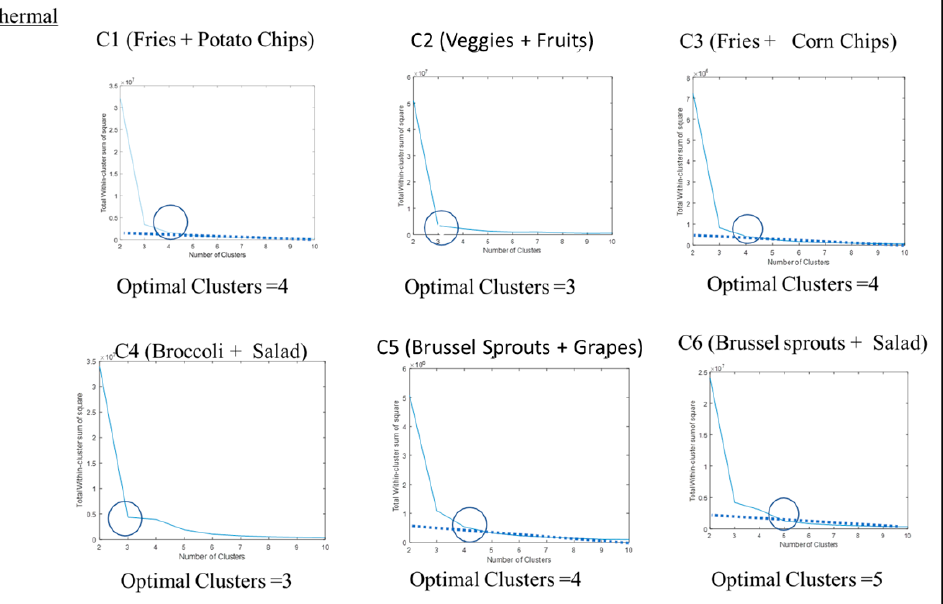
Figure A3. WSS Optimization scheme to determine the number of optimal clusters in thermal data.